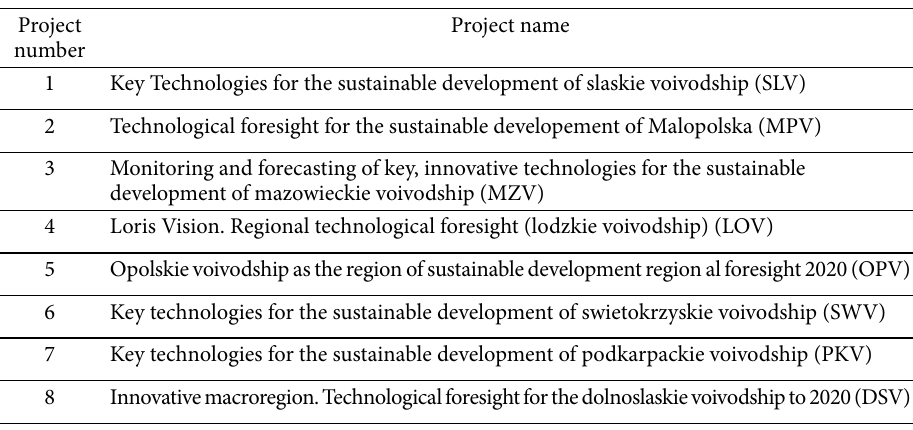
Table 2. List of the regional foresight projects in which scenario method has been applied Project